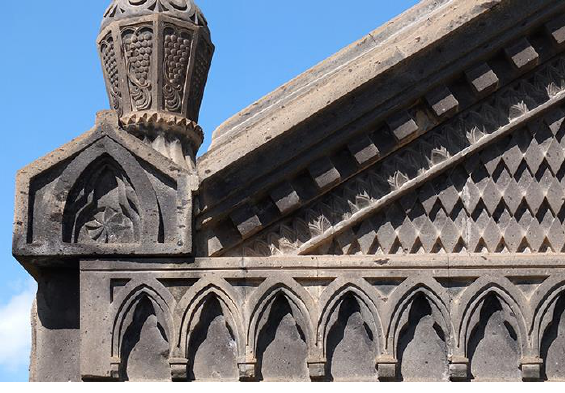
Figure 13. Fragment of the Gyumri’s vernacular ensemble: